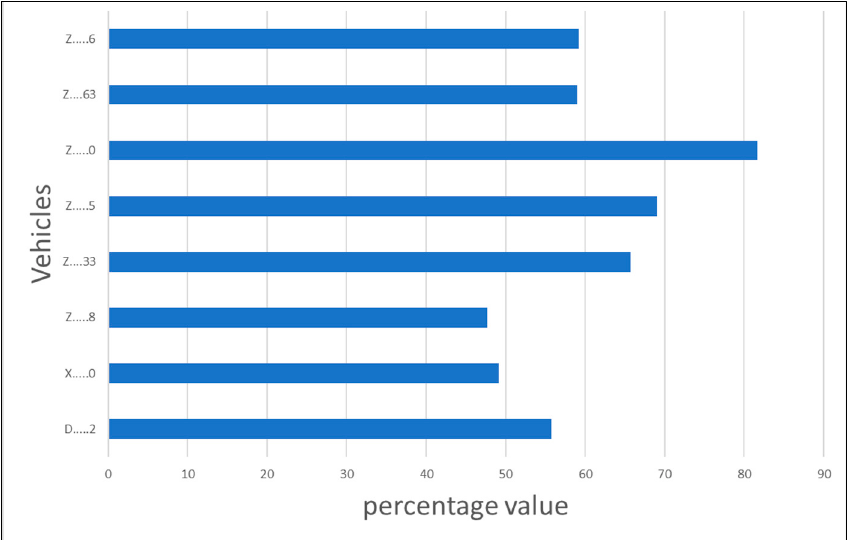
Figure 12. Relative daily efficiency—the weighted ratio of the number of transported pallets to the amount of fuel consumed over a distance of 100 km, expressed in [%], where the reference is the most effective day from a given 3-month period.